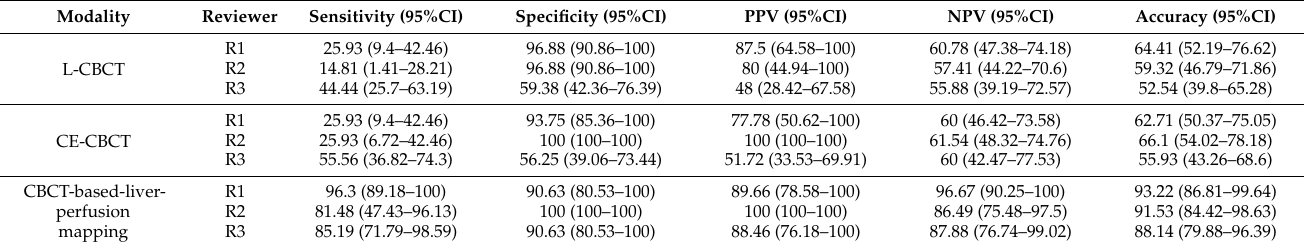
Table 3. Diagnostic performance of treatment response evaluation on different imaging modalities after transarterial chemoembolization for hepatocellular